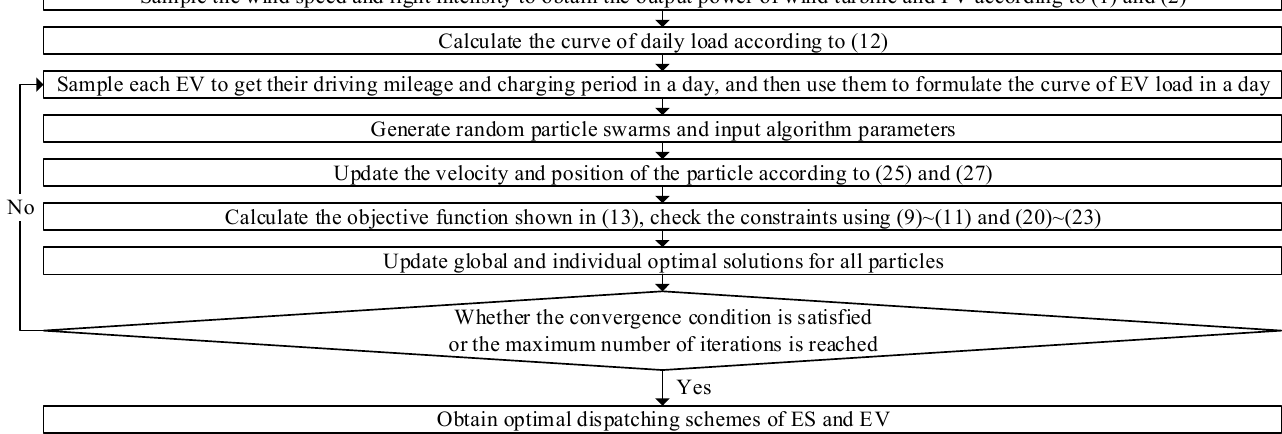
Figure 1. Solving process of optimal dispatching model for ES and EV. 4. Distribution Network Reconfiguration Model and Solving Algorithm 4.1. Objective Functions is the economy function described by the network power losses shown in (29).